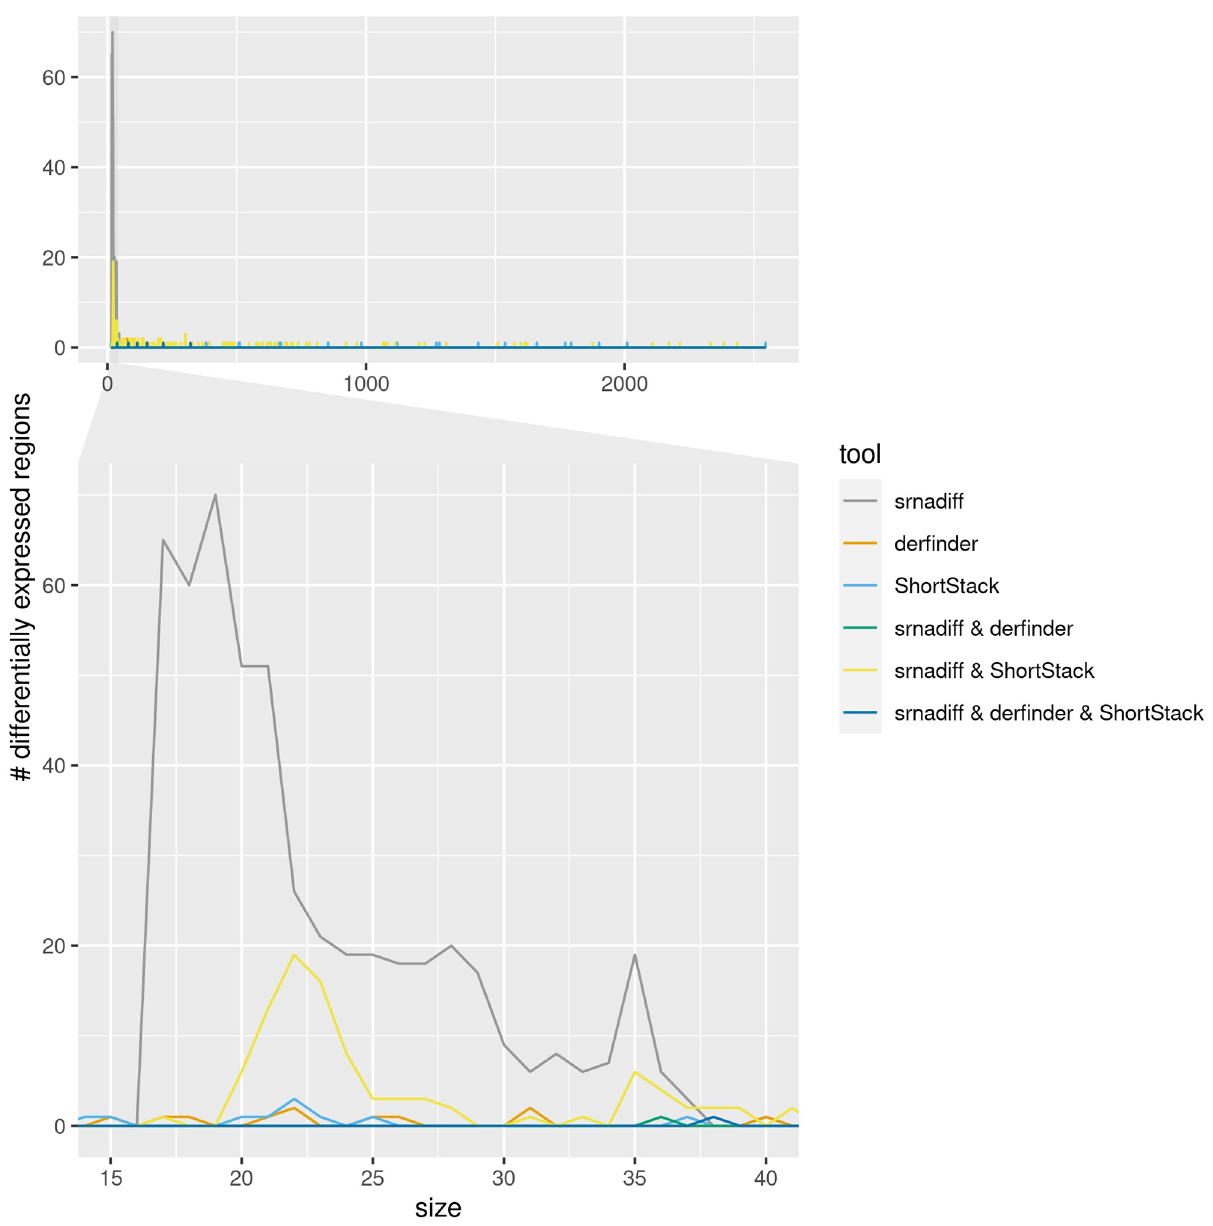
Fig 6. Size distribution of uncharacterized differentially expressed regions. The top figure shows the distribution of the size of the differentially expressed regions outside of known miRNAs, piRNAs, tRFs, snoRNAs, found by one of the tools, or a combination thereof. The bottom figure zooms on the 15–40 size distribution.